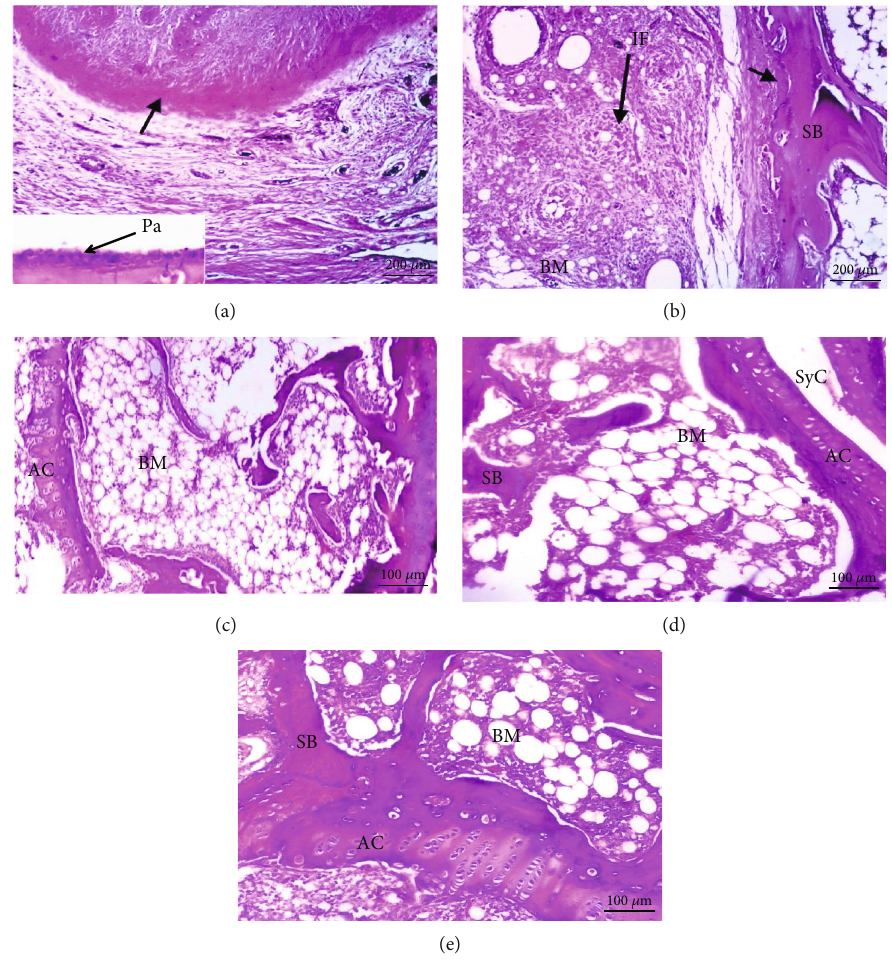
Figure 3: Photomicrographs of sections in the ankles of male rats. (a) From the RA group showing necrosis of articular cartilage ( ↗ ). The insert shows pannus formation ( ↙ ). (b) From the RA group showing necrosis of articular cartilage ( ↓ ) and in fl ammatory cell in fi ltration (IF). (c – e) From arthritic-treated groups with curcumin, MSCs, and a combination of curcumin and MSCs, respectively, showing a nearly normal structure of articulating cartilage (AC), synovial cavity (SyC), sponge bone (SB), and bone marrow